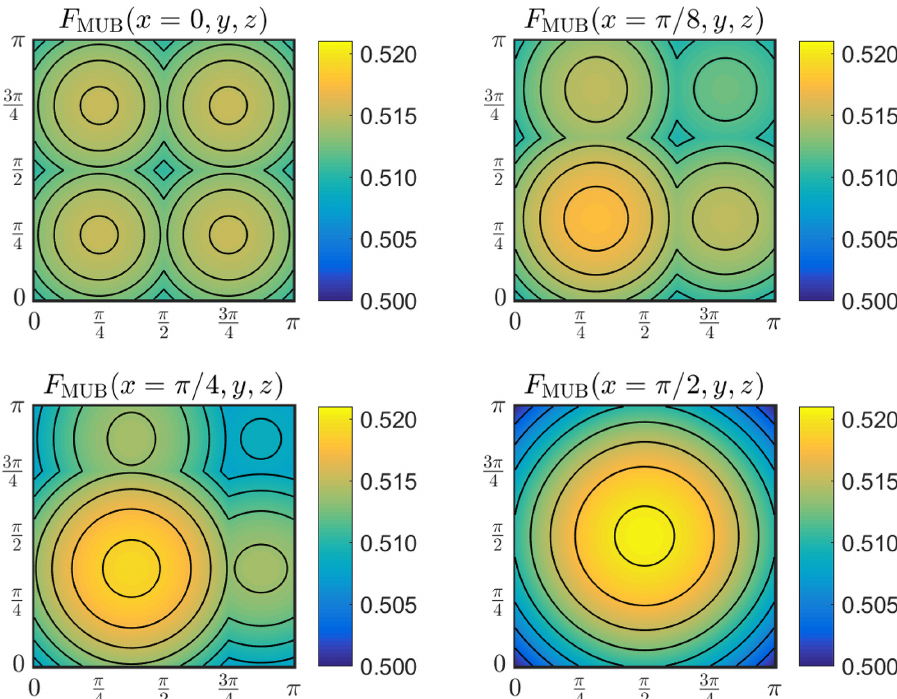
FIG. 7. Contour and color plots of the three-copy estimation fidelity F MUB ( x , y , z ) [cf. Eq. (94)] for four cross sections that are parallel to the y - z plane as specified by four different values of x